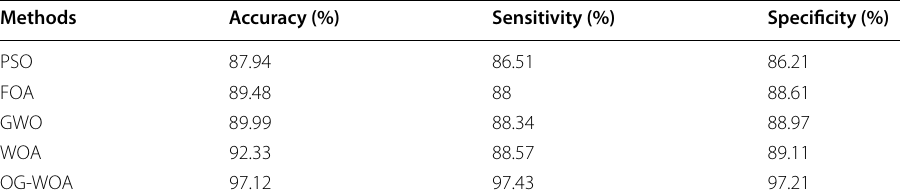
Table 1 Performance analysis of different optimization algorithm for feature selection on AID dataset